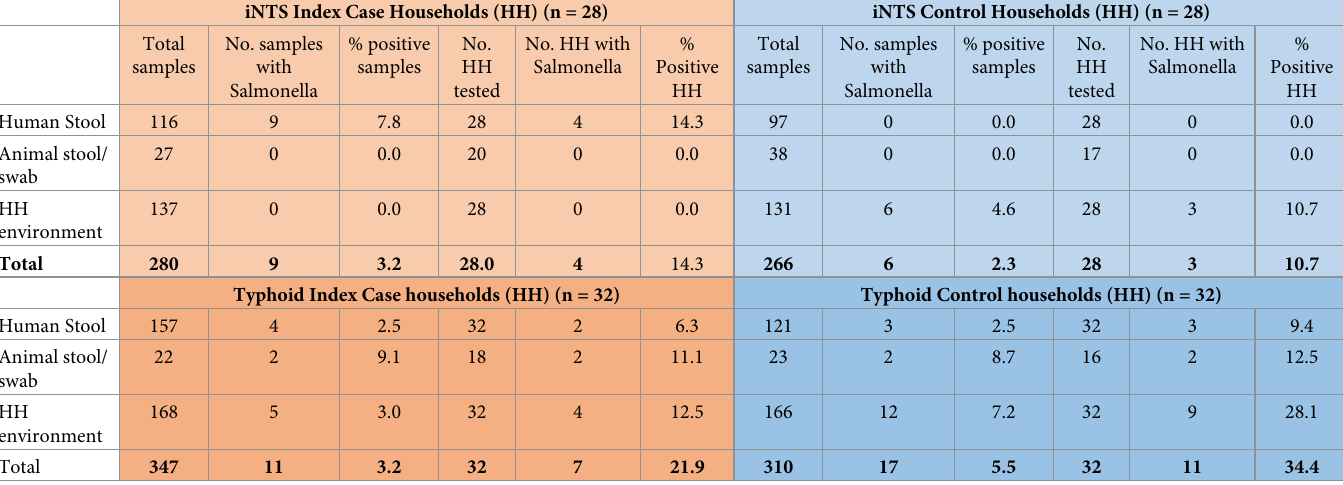
Table 2. Sources of Salmonella isolates from case and paired control households linked to iNTS and typhoid patients. HH stands for household, and an index case refers a diagnosed case of invasive Salmonellosis . iNTS Index Case Households (HH) (n =